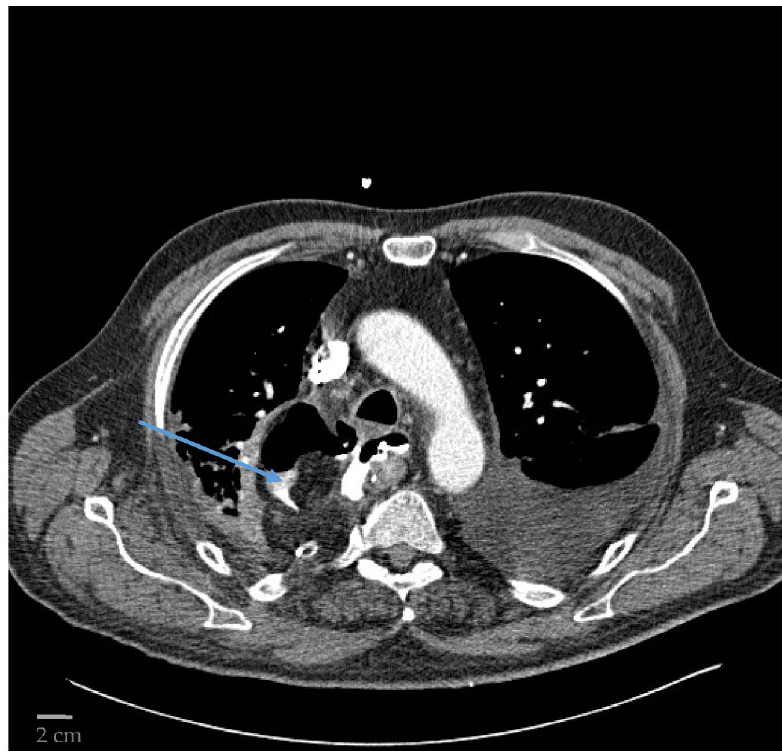
Figure 1. CT displaying an AL with extravasation of contrast agent and free air in the mediastinum indicated by the blue arrow.